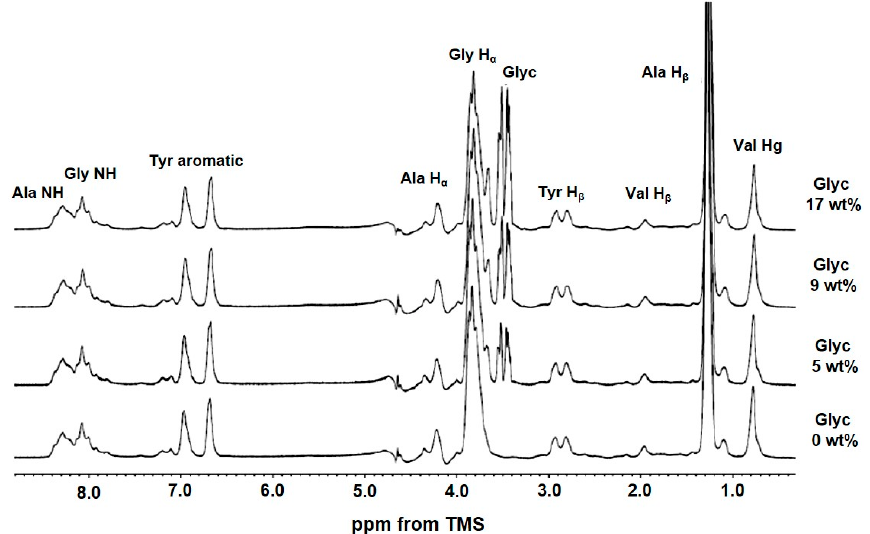
Figure 4. 1 H solution NMR spectra of regenerated SF aqueous solutions observed by changing Glyc concentration. The assignments are given on top of the peaks.